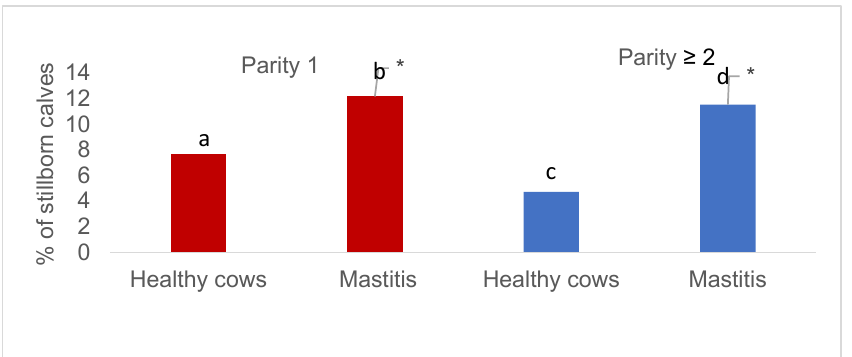
Figure 2. Percentage of stillborn calves by parity and groups of cows by health condition. *—the difference between the frequencies is statistically significant ( p < 0.05).